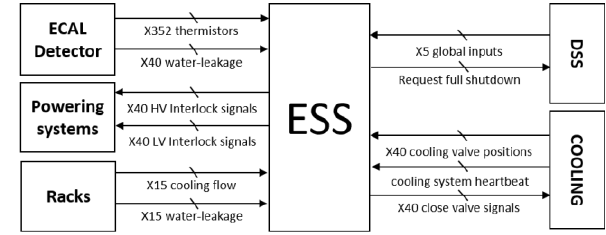
Fig. 1. Simplified diagram of hardware